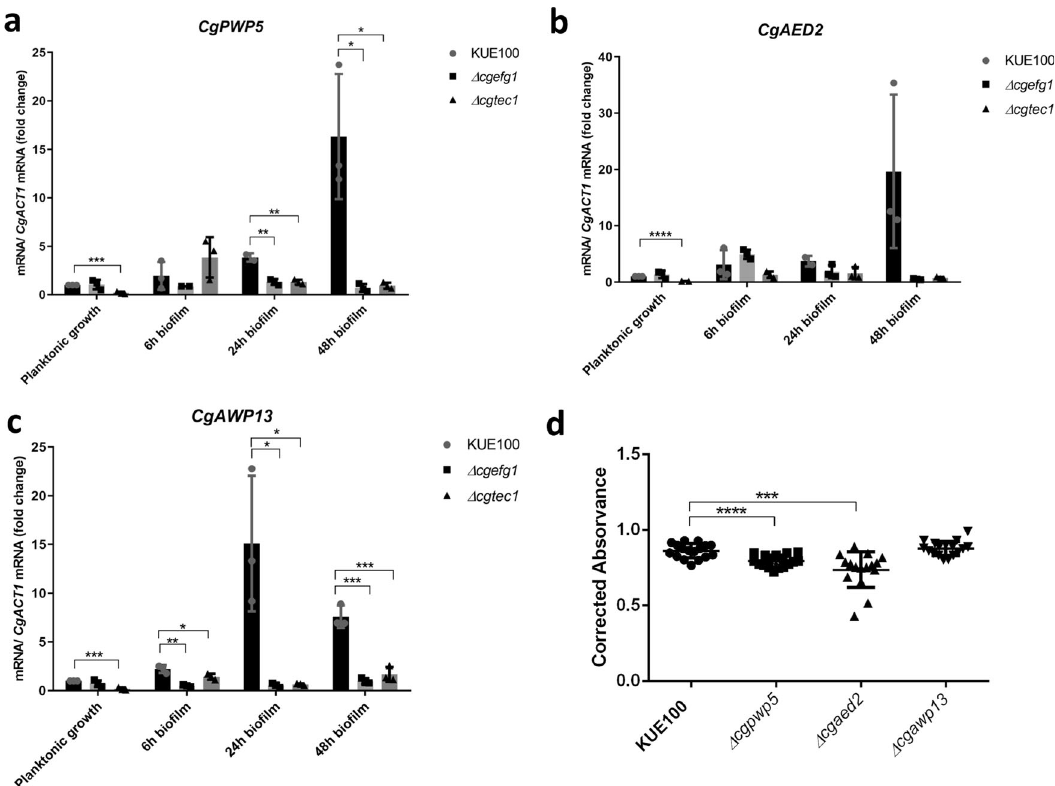
Fig. 6 CgPwp5, and CgAed2 adhesins are necessary for bio fi lm formation, being regulated by CgEfg1 and CgTec1 transcription factors. Shown are the transcript levels of: a CgPWP5 , b CgAED2 , and c CgAWP13 in the C. glabrata wild-type strain KUE100 and in the derived deletion mutants Δ cgefg1 and Δ cgtec1 , in planktonic conditions and 6, 24, and 48 h of bio fi lm formation conditions on polystyrene surface in liquid SDB medium, pH 5.6. Transcript levels were assessed by quantitative RT-PCR, as described in “ Methods. ” Values are averages of results from at least three independent experiments. Error bars represent SDs. d Twenty-four-hour bio fi lm formation quanti fi ed by Presto Blue Cell Viability Assay in microtiter plates of C. glabrata KUE100 wild-type and Δ cgpwp5 , Δ cgaed2 , and Δ cgawp13 deletion mutant strains grown in SDB medium, pH 5.6. The data are displayed in a scatter dot plot, where each dot represents the level of bio fi lm formed in a sample. Horizontal lines indicate the average levels from at least three independent experiments. Error bars indicate SDs. * P < 0.05; ** P < 0.01, *** P < 0.001; **** P < 0.0001, n ≥